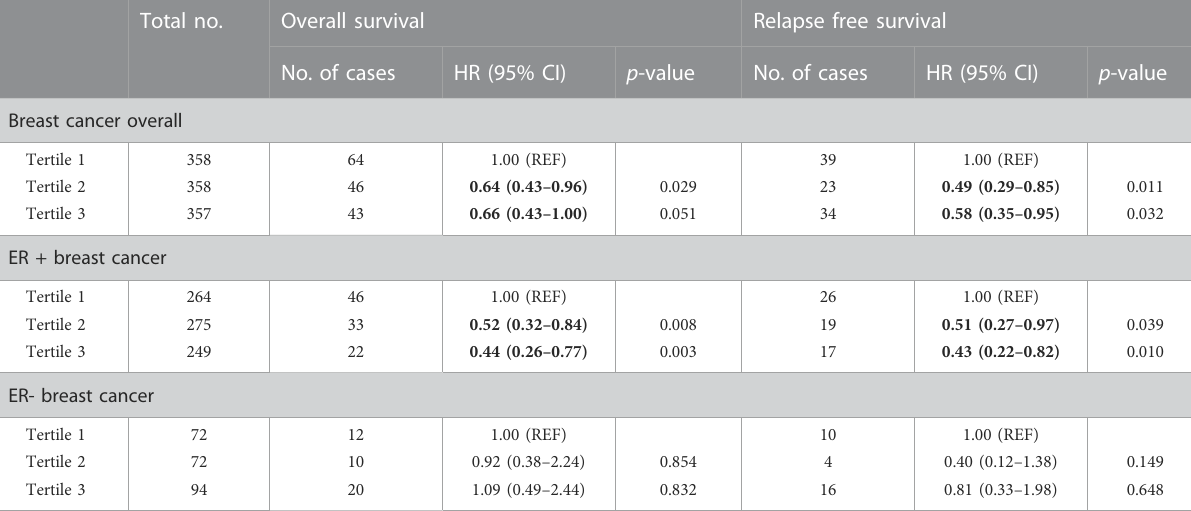
TABLE 3 The association between CCL19 and survival of breast cancer patients in TCGA cohort. Total